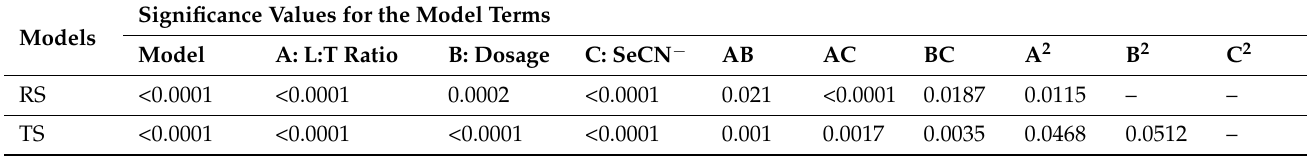
(Table 4) show that the reduced quadratic equation yields a good model for SeO 42- residual, whereas for total selenium removal, the logit-transformed full quadratic model showed the best results. For the RS model (Equation (7)), the significance of the model terms with p -values < 0.05 shows that the respective terms significantly contribute toward improving the model results [68]; however, for the TS model (Equation (8)), only the term B 2 has a p -value slightly higher than 0.05. Table 4. RSM modeling parameters for the RS and TS models.